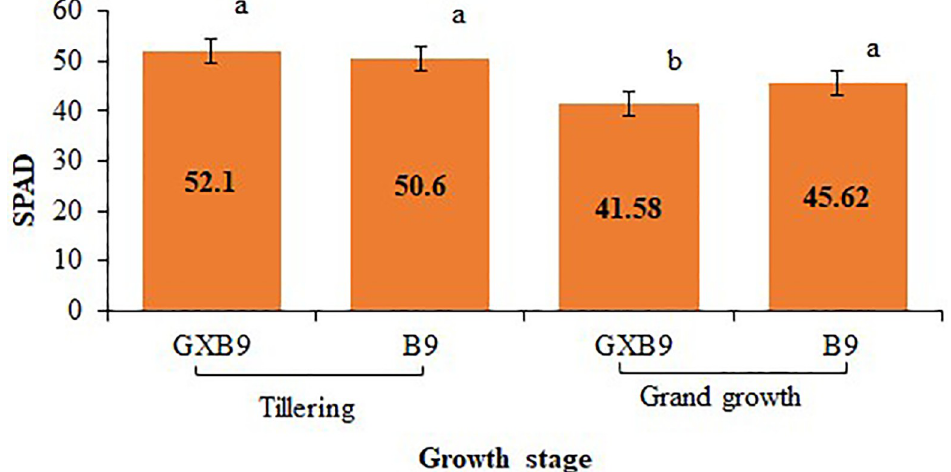
Fig 8. SPAD in GXB9 and B9. Values labeled with the same letters above columns are not significantly different at p �